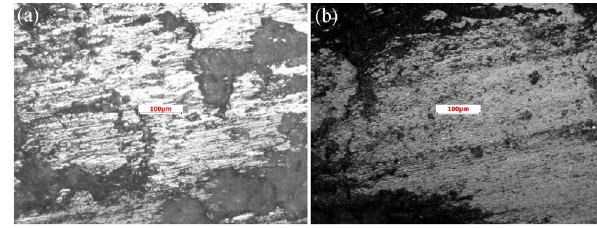
Fig. 8 Optical microscopy images of Y-TZP (a) and Y-TZP-Al 2 O 3 (b) worn surfaces on sliding at 1 m/s 26